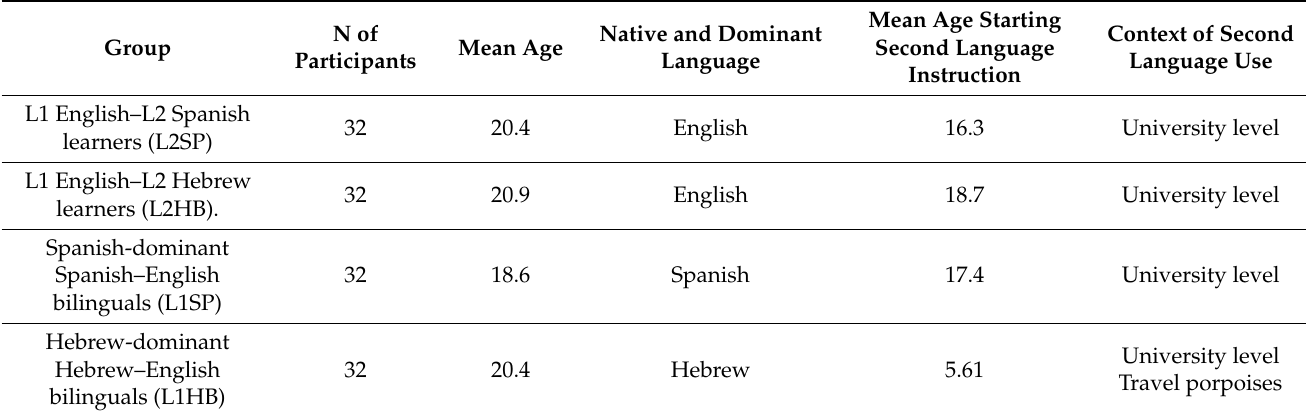
Table 7. Demographics of the